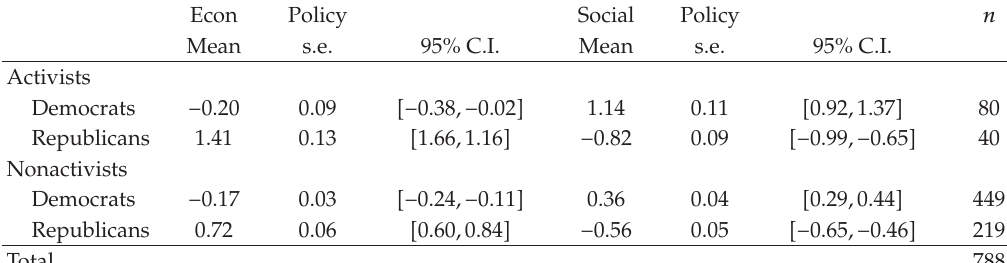
Table 6: Descriptive data.